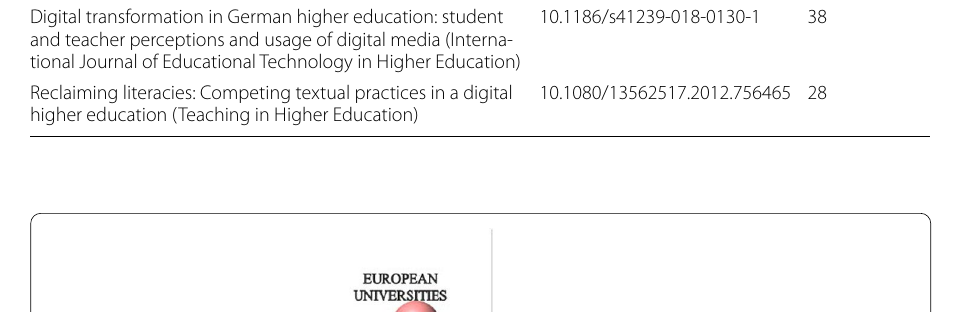
Factors affecting faculty use of learning technologies: Implica‑ tions for models of technology adoption (Journal of Comput‑ ing in Higher Education) Openness and praxis: Exploring the use of open educational practices in higher education (The International Review of Research in Open and Distributed